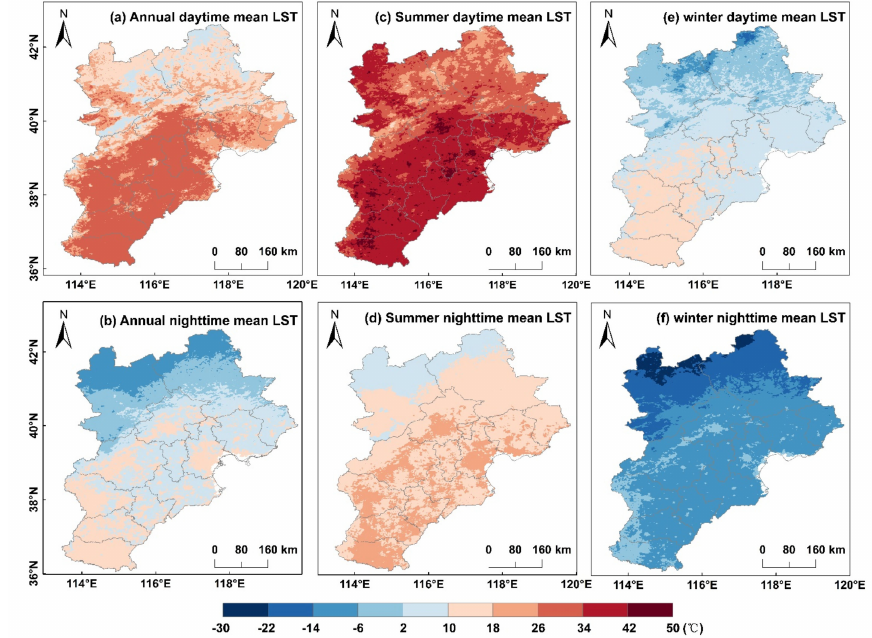
Figure 4. Spatial distribution of land surface temperature (LST) across the BTH region, ( a ), ( c ) , and ( e ) denote spatial distribution of annual, summer and winter daytime mean LST; ( b ), ( d ) , and ( f ) denote spatial distribution of annual, summer and winter nighttime mean LST.